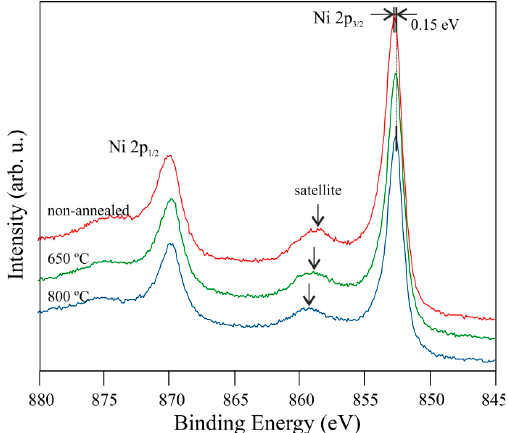
Figure 21. XPS spectra of Ni-2p for a Ni-film-covered GaN(0001) surface, showing the impact of annealing. Mean Ni-film thickness is 3 nm. Reprinted with permission from [29]. Copyright 2014 Elsevie.